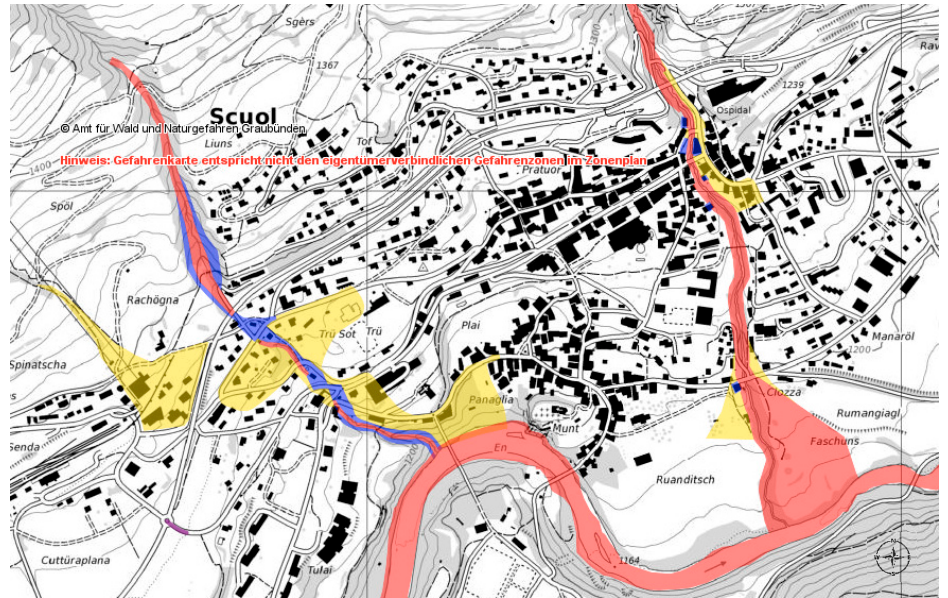
Figure 7. Natural hazard risk map of Scuol: flood risk zones (Latitude: 46.796872| Longitude: 10.297738; © Canton of Grisons).